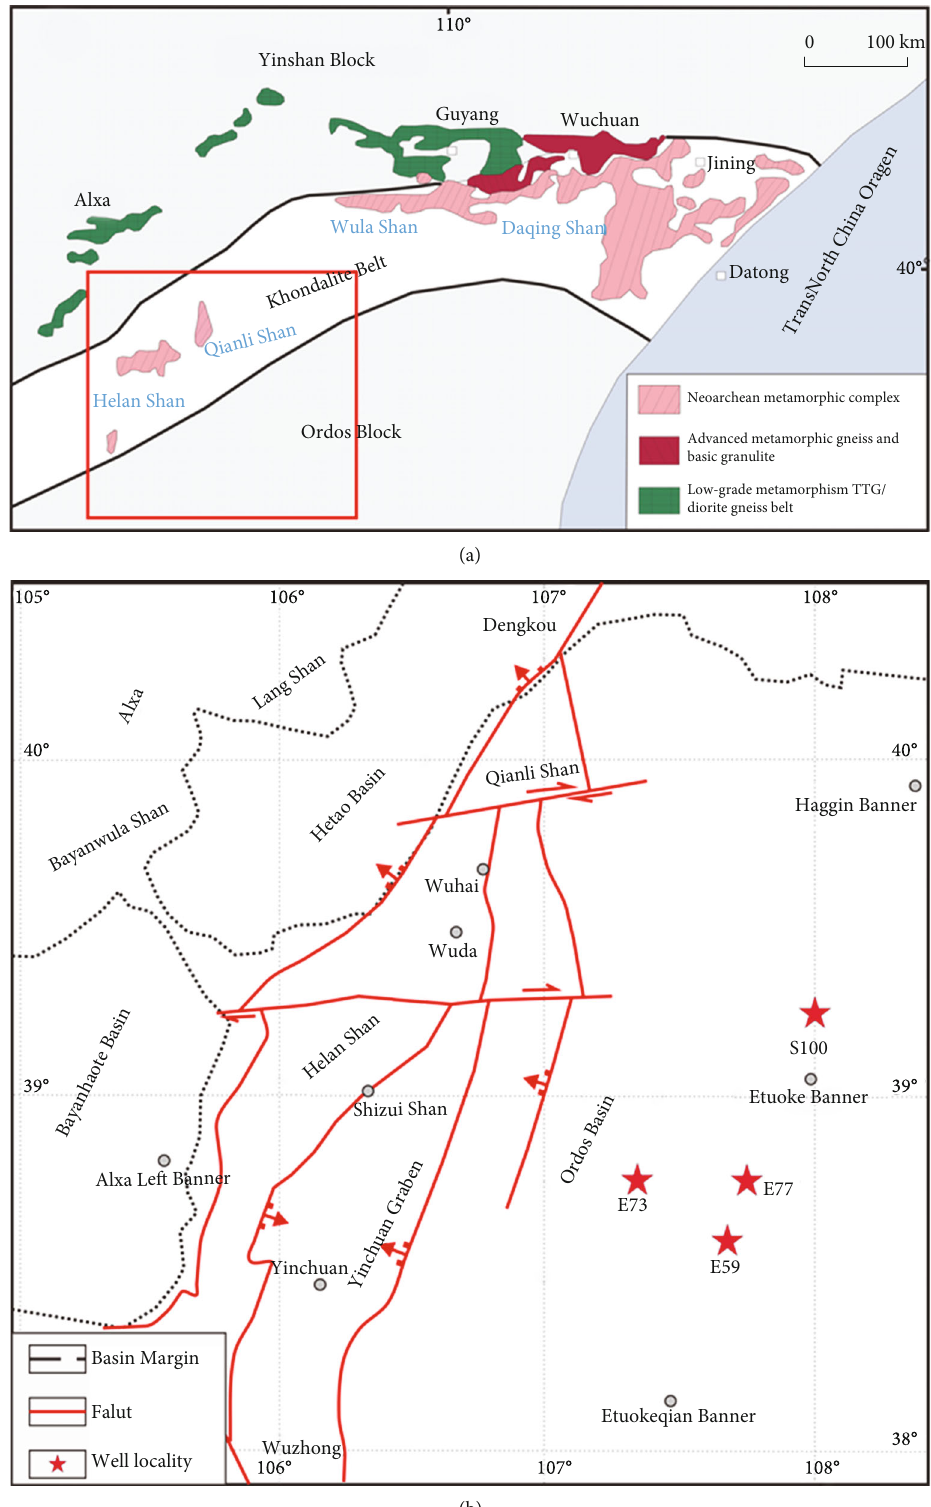
Figure 1: Geological map of the study area. (a) Distribution map of the metamorphic basement in the northern Ordos Basin (modi fi ed after [1]). (b) Structural map of the northwestern Ordos Basin (modi fi ed after Li Meng et al.,